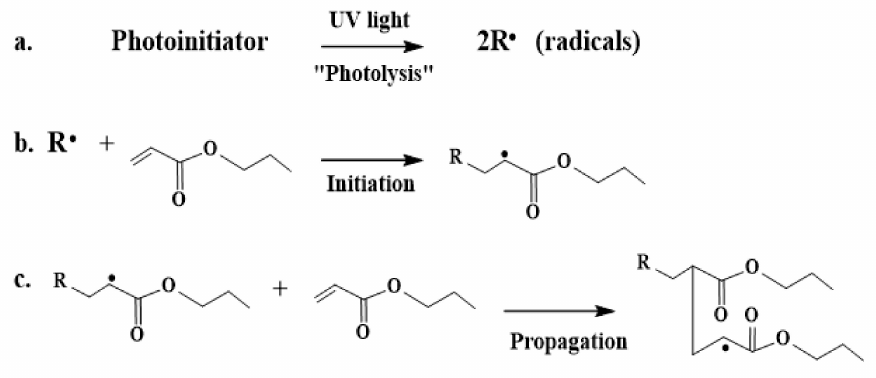
Figure 3. Primary mechanism of free radical polymerisation under UV radiation of ( a ) photolysis, ( b ) initiation, and ( c ) propagation.